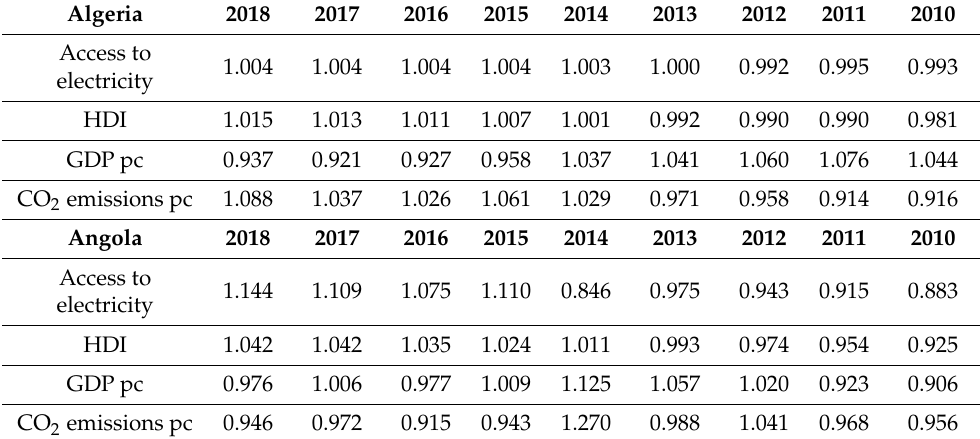
Table 3. Time series standardized against their arithmetic means for two selected African countries.